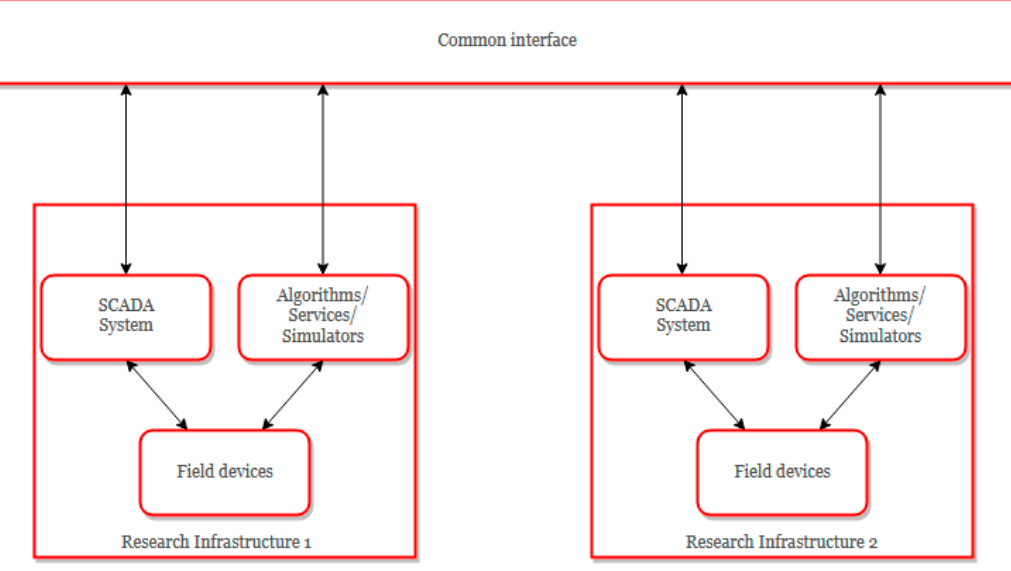
Figure 1. Virtual research infrastructure concept.